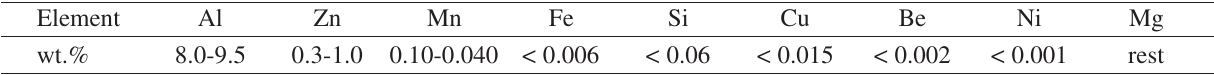
Element Al Zn Mn